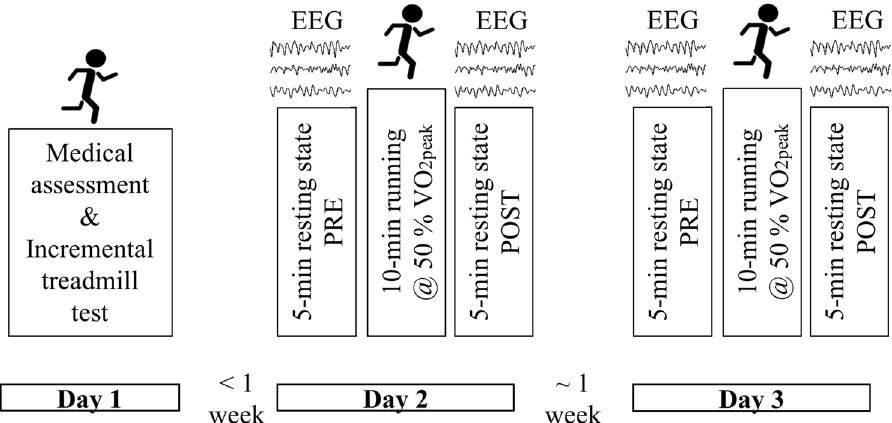
Figure 4. Overview of the experimental procedure to investigate test–retest reliability of graph measures in a resting situation after exercise. Day 1 consisted of a medical assessment and an incremental treadmill test to assess peak oxygen uptake (VO 2peak ). On day 2 and 3, electroencephalography (EEG) resting state was assessed before (PRE) and after (POST) running for 10 min at the speed corresponding to 50% of individual VO 2peak